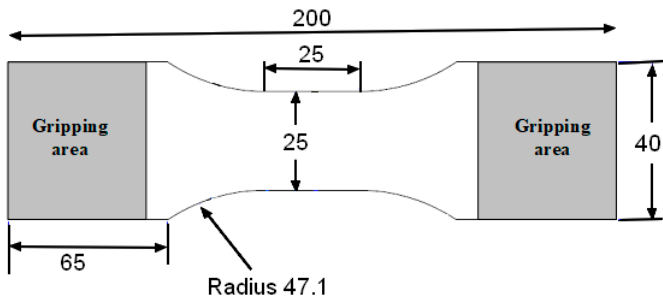
Table 2. The number of turning points in each spectrum.